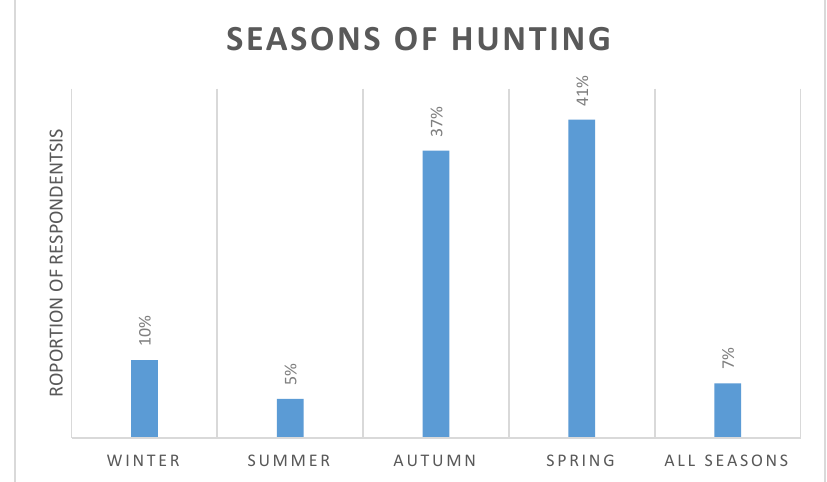
Figure 2. Distribution of responses regarding the main seasons for illegal hunting of wildlife in the northern section of Bardia National Park, Nepal ( n = 41).